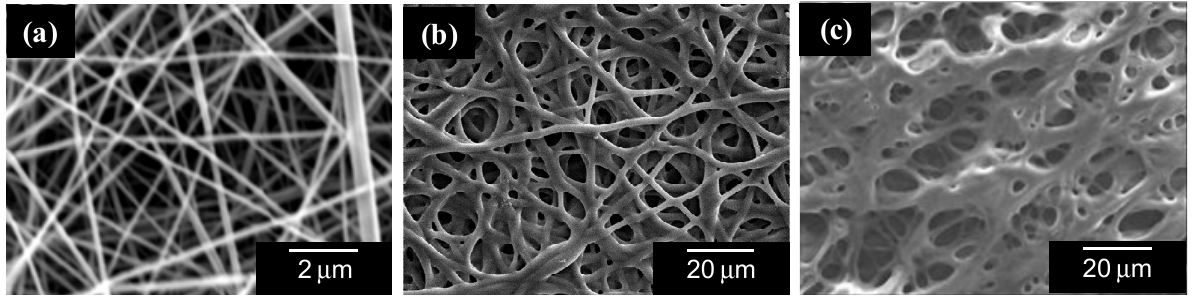
Figure 6. Surface scanning electron micrographs of the typical ion-exchange NFMs: ( a ) chitosan NFM (Adapted from [23]); ( b ) sulfonated PS NFM (Adapted from [21]); and ( c ) quaternized P4VP NFM (Adapted from